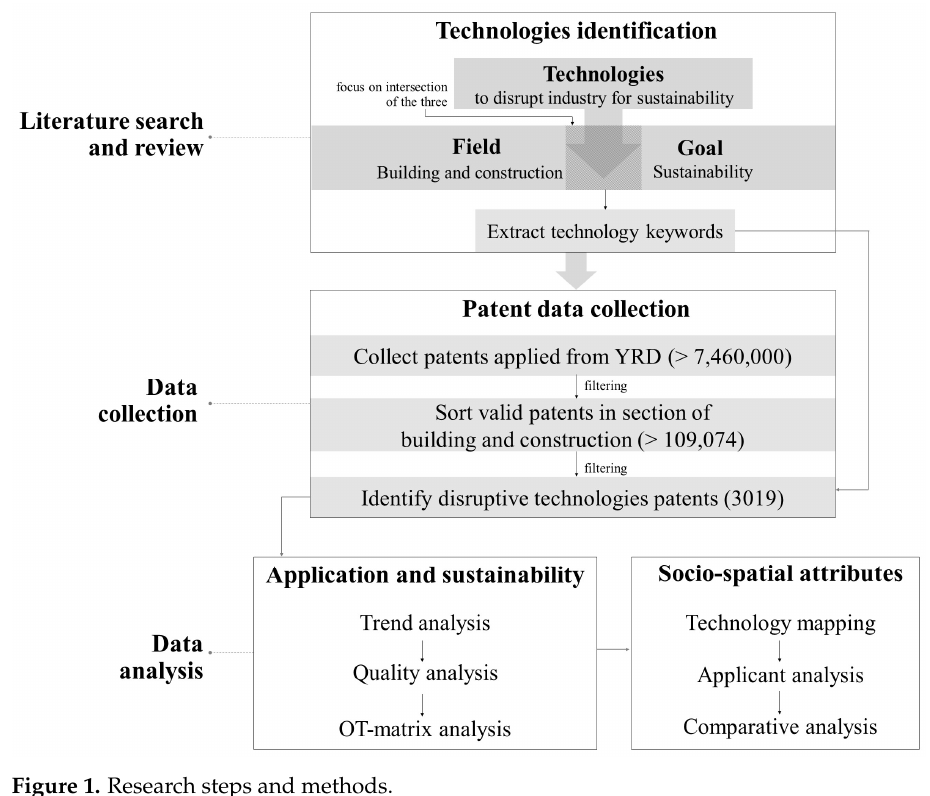
Figure 1. Research steps and methods.